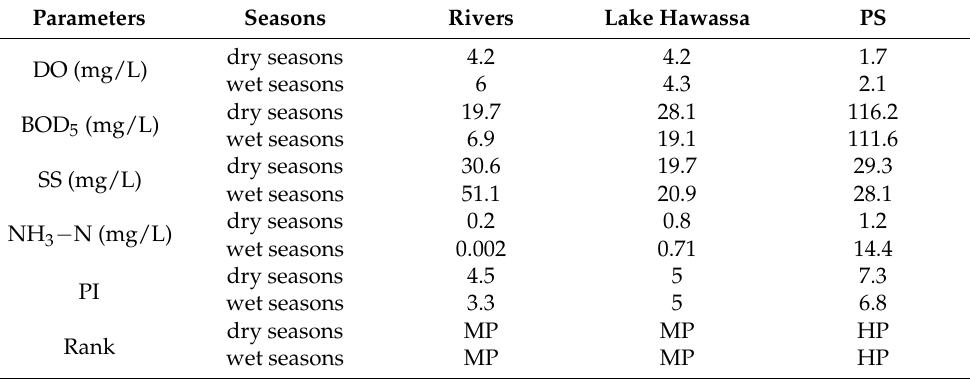
Table 7. Average concentrations of monitoring stations for rivers, Lake Hawassa, and point sources (PS) observed in both dry and wet